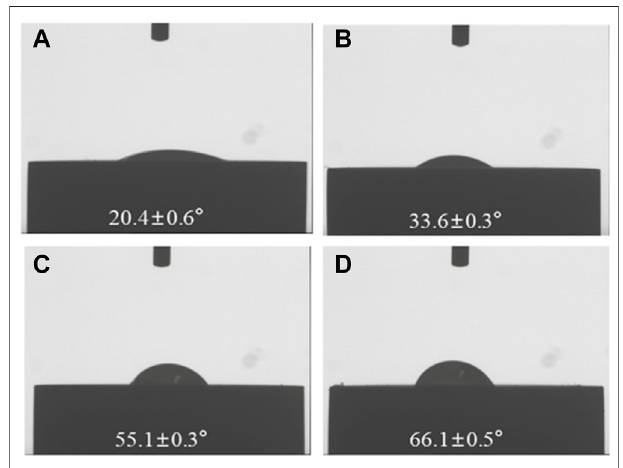
FIGURE 6 | Contact angles of the different samples.